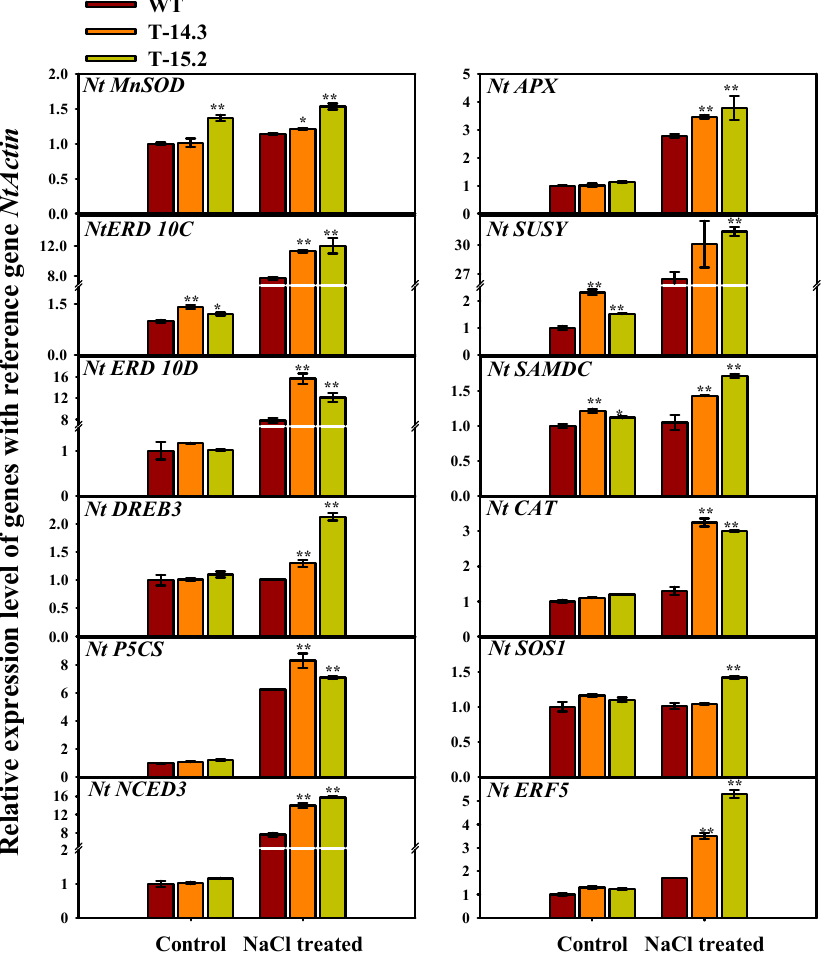
Figure 17. Real-time expression analysis of stress responsive genes in WT and AnnAt8 transgenic tobacco seedlings before and after salt treatment to the seedlings, data represent means of n = 3 ± SE. An asterisk indicates that the mean values of transgenic lines were significantly higher than those of WT when analyzed by one-way ANOVA at p < 0.05 and two asterisks at p < 0.01.